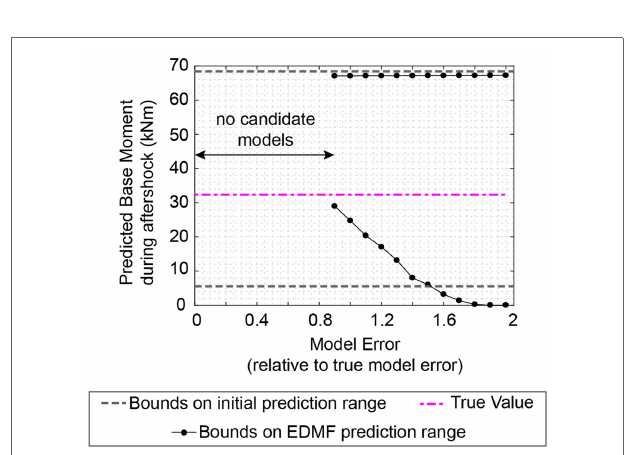
FIGURE 13 | Evolution of the maximum base moment prediction range during an aftershock. No candidate models were found for model uncertainties smaller than 90% of the model uncertainty derived using the true